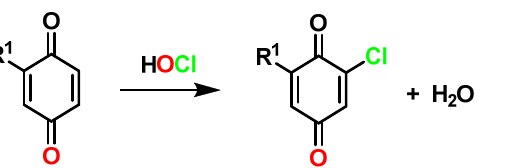
Figure 31. Formation of chloroquinones in the oxidation of phenols with chlorine dioxide.